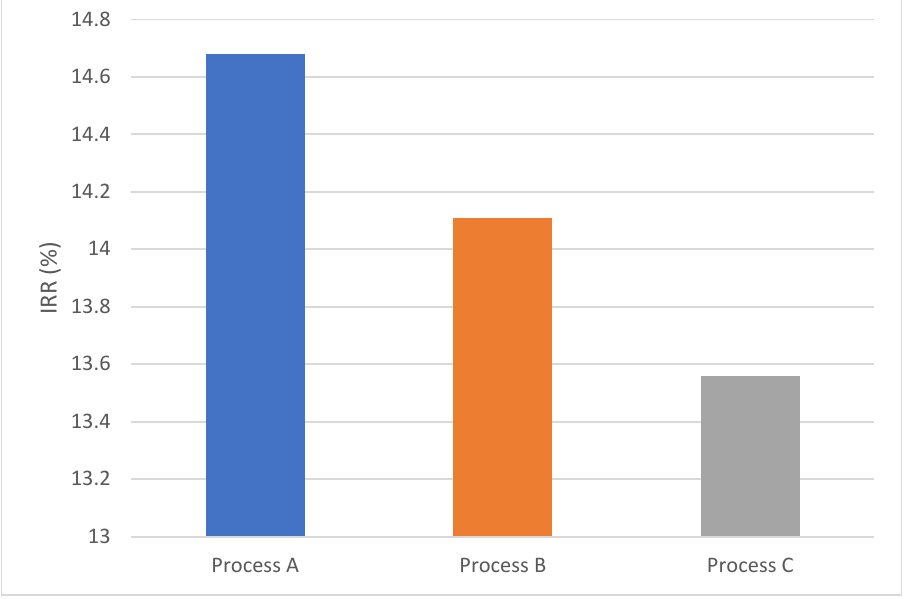
Figure 12. IRR of designed system.